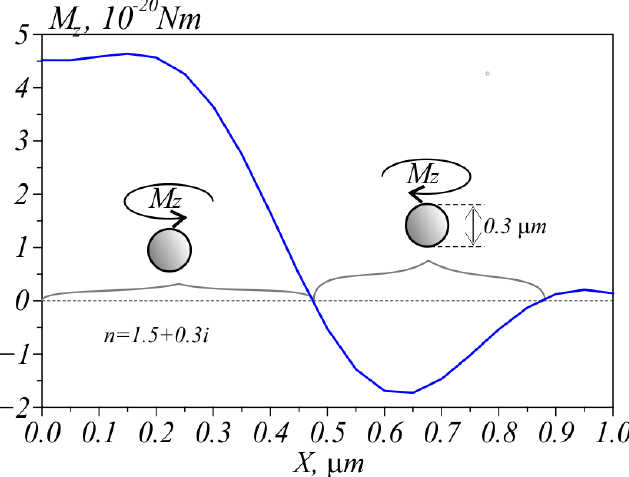
Figure 4. Projection Mz of the torque exerted on an off-center microparticle along the x -axis (X = Y = 0, and Z = f). The refractive index of the microparticle: n = 1.5 + 0.3 i ; beam power: 100 mW. From Figure 4, the torque is seen to be maximal near the center (at distance of ap- proximately X = 0.2 µm), making the microparticle rotate anticlockwise according to the on-axis polarization handedness. Note that the maximal torque value M z > 0 coincides with the maximal value of the longitudinal SAM component S z seen in Figure 4 on the horizontal x -axis (Figure 3b). Then, as the particle is moved off the center in the positive direction of the x -axis, the torque decreased and reversed its sign, before again becoming maximal in the absolute value at a point X = ~0.6 µm and having clockwise handedness (the ring region where Sz was negative in Figure 2c,d). From Figure 2e, the polarization was seen to again become elliptical with the E -vector rotating clockwise, similar to the torque M z